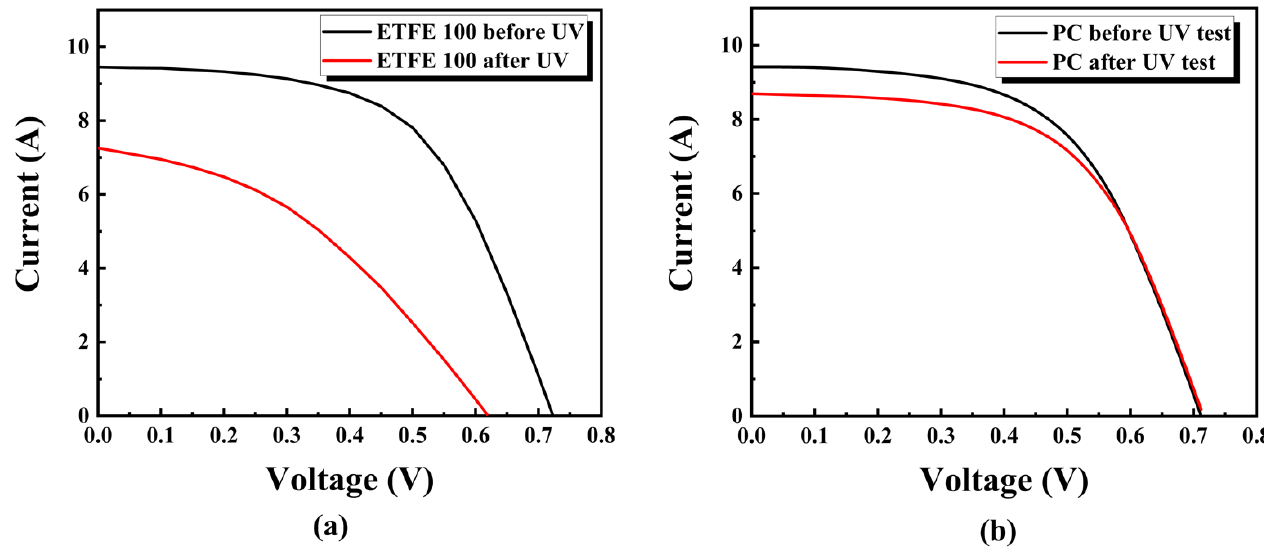
Figure 6. I–V curve of the lightweight one-cell PV module using ( a ) ETFE and ( b ) PC as a front cover sheet before and after the UV test.